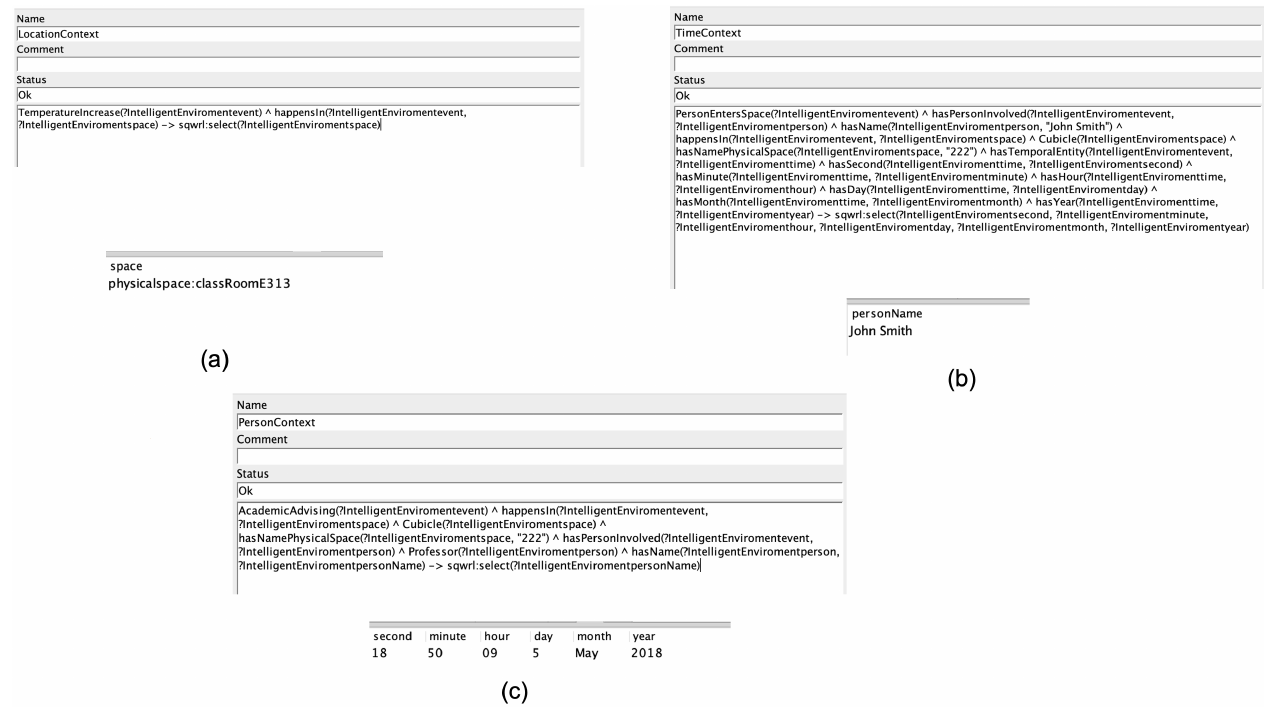
Figure 11. Results of competence questions with context